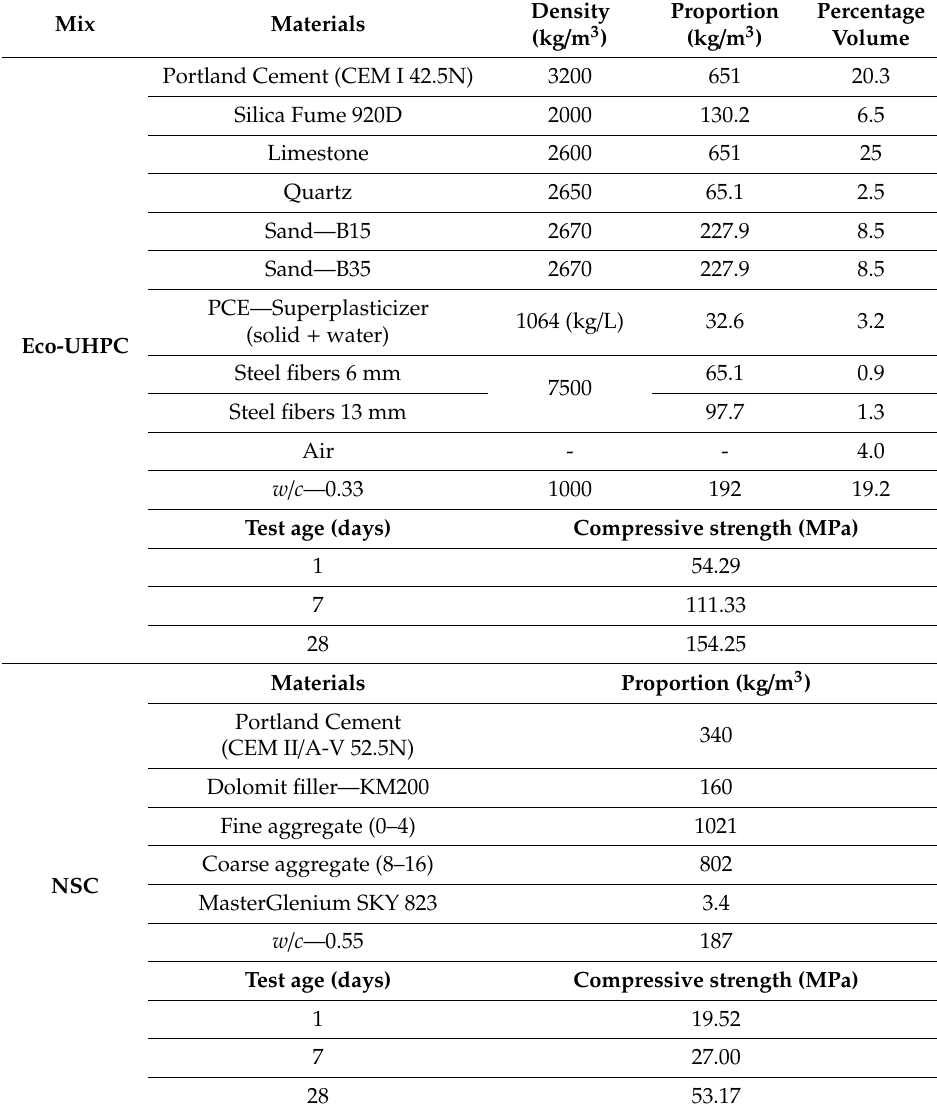
Table 1. Mix proportion and mechanical properties—Eco-UHPC and Normal concrete.